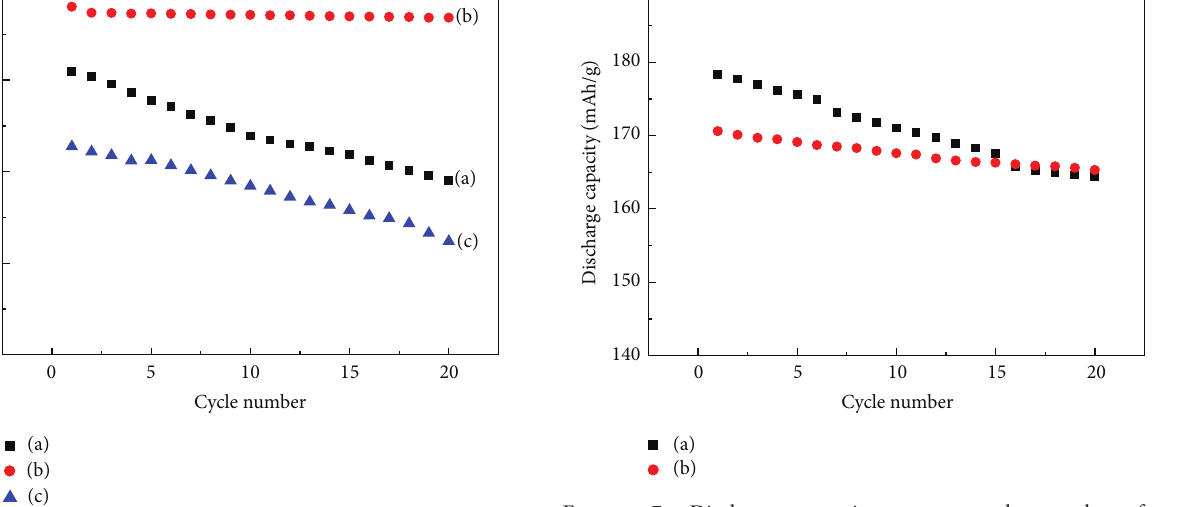
Figure 7: Discharge capacity versus cycle number for Mg 𝑥 Co 0.3 O 2 ( 0 ≤ 𝑥 ≤ 0.1 ) cell at 0.1C and 55.5 ∘ C Li / LiNi 0.7 – 𝑥 in 2.0–4.4 V: (a) 𝑥 = 0 ; (b) 𝑥 = 0.1 .